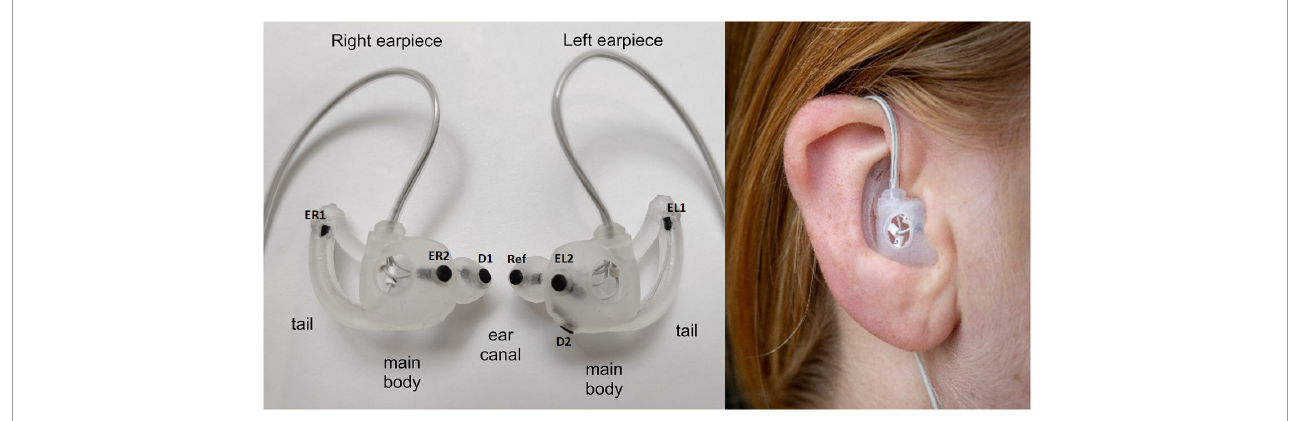
FIGURE1 (Left) Generic earpieces with mounted electrodes. The placement of the three main features (ear canal, tail, and main body) are specified for each earpiece. The generic earpiece was molded in soft silicone in one piece to ensure good comfort. Cable relief was incorporated in the design to reduce movement artifacts from cable pulling. Also, a formed tube was designed to guide the cables behind the ear to further reduce cable movement, to increase comfort and to make the earpiece more discrete. EL1, EL2, ER1, and Er2: data electrodes, D1 and D2 ground electrodes, ref: reference electrode. (Right) Earpiece mounted in the ear.